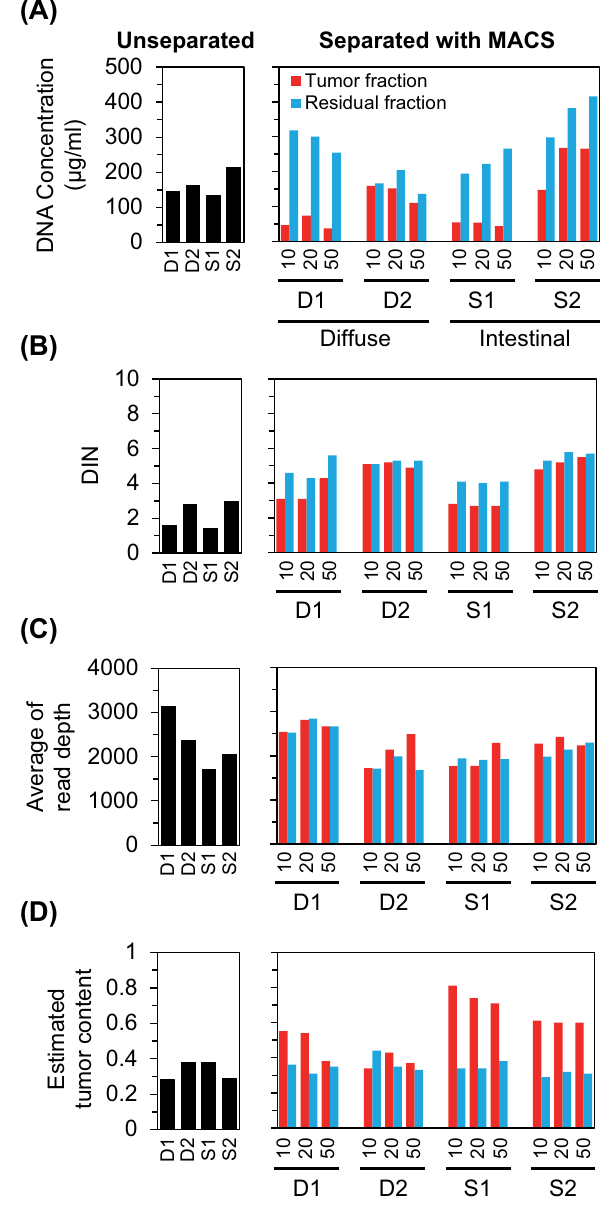
Figure 3. Quality of DNA, read depth, and estimated content of tumor obtained from formalin-fixed paraffin- embedded (FFPE) tissue sections. DNA concentration ( A ), DNA integrity number (DIN) ( B ), read depth ( C ), and estimated tumor content ( D ) in the FFPE tissue sections of different thickness (10, 20, and 50 µm). The suspensions enriched with the microbeads are defined as tumor fractions, and samples that could not be captured with these beads are designated as residual fractions. The samples obtained from 10 µm thick FFPE tissue sections that were not subjected to magnetic-activated cell sorting (MACS) are represented as unseparated. The numbers above the sample names in the panels for “Separated with MACS” indicate the thickness of the FFPE tissue